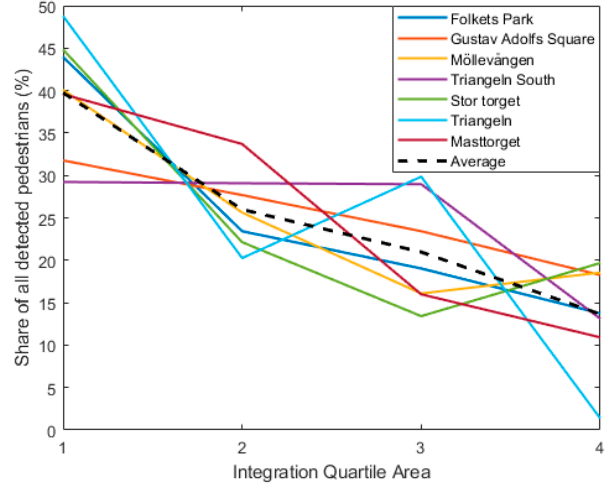
Figure 8. The relationship between integration level and the share of pedestrian detections.